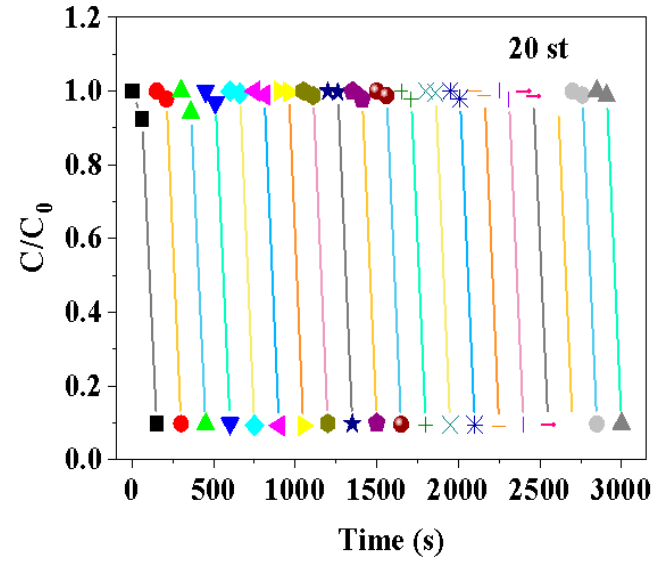
Figure 8. Cycling properties of MB for 20 cycles.